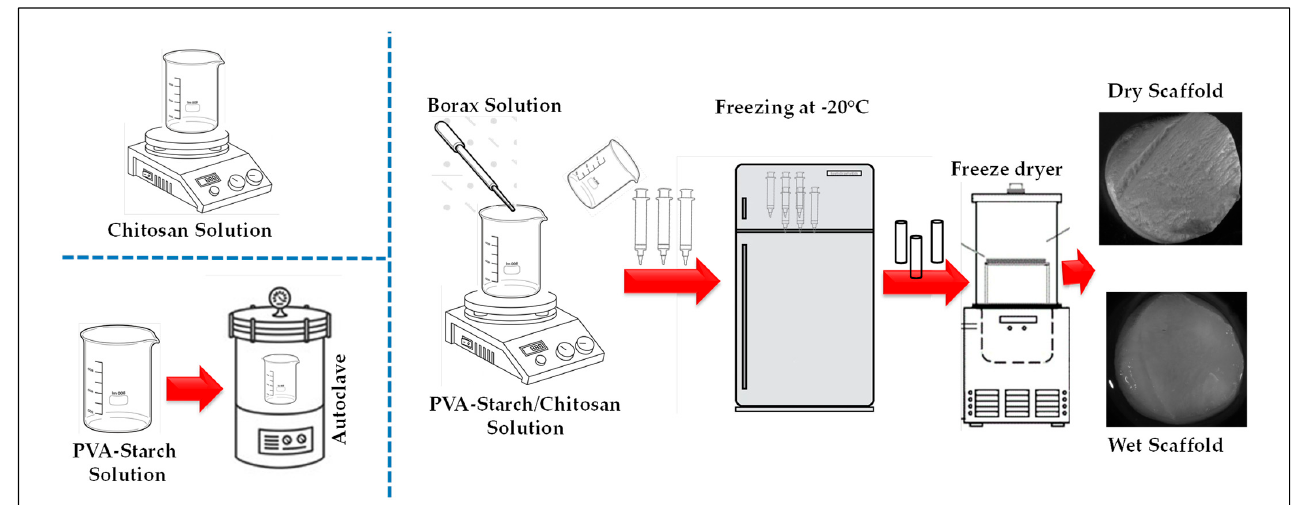
Figure 1. Schematic overview of the production steps for the P:S/C cryogel sca ff olds.